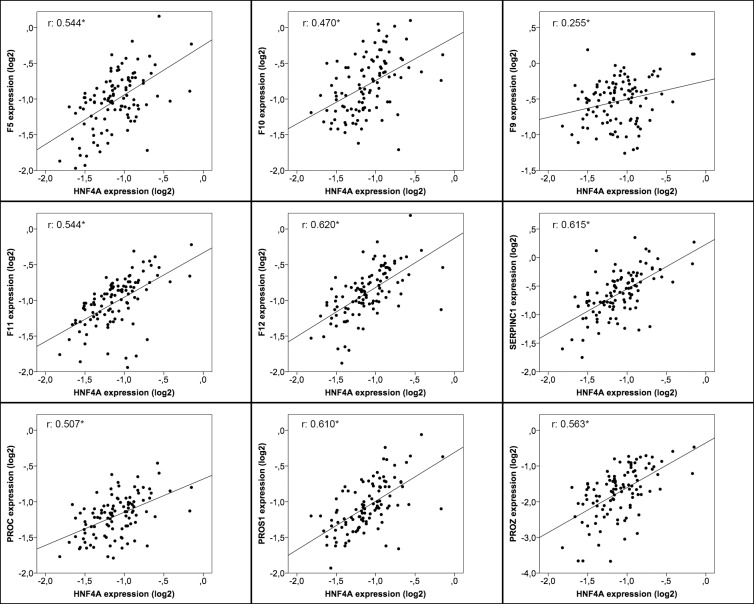
Correlation of mRNA expression levels of pro- and anti-coagulant factors with hepatic transcription factor HNF4A.Positive and significant correlations between procoagulant (F5, F9, F10, F11, and F12), anticoagulant (SERPINC1, PROC, PROS1, and PROZ) factors and HNF4A mRNA expression. qRT-PCR was performed in total RNA purified from healthy livers (n = 104). Each data point represents an individual liver tissue sample, and a correlation coefficient (r) is shown. The results are presented as Log2 fold change with respect to the normalization standard. The asterisk indicates a statistically significant difference (p < 0.0001).